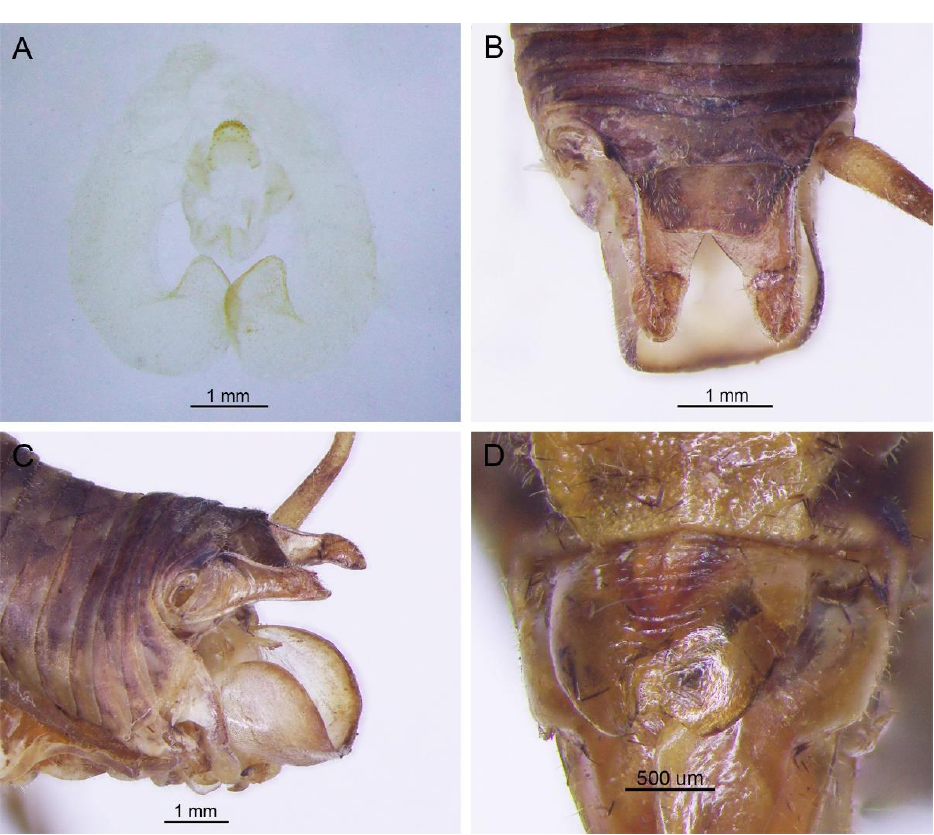
Figure 8. Type specimens of Pseudotachycines volutus . ( A ) dorsal view of male genitalia; ( B , C ) apex of abdomen: ( B ) dorsal view, ( C ) lateral view; ( D ) subgenital plate in ventral view. Pseudotachycines procerus Zhu & Shi sp. nov.